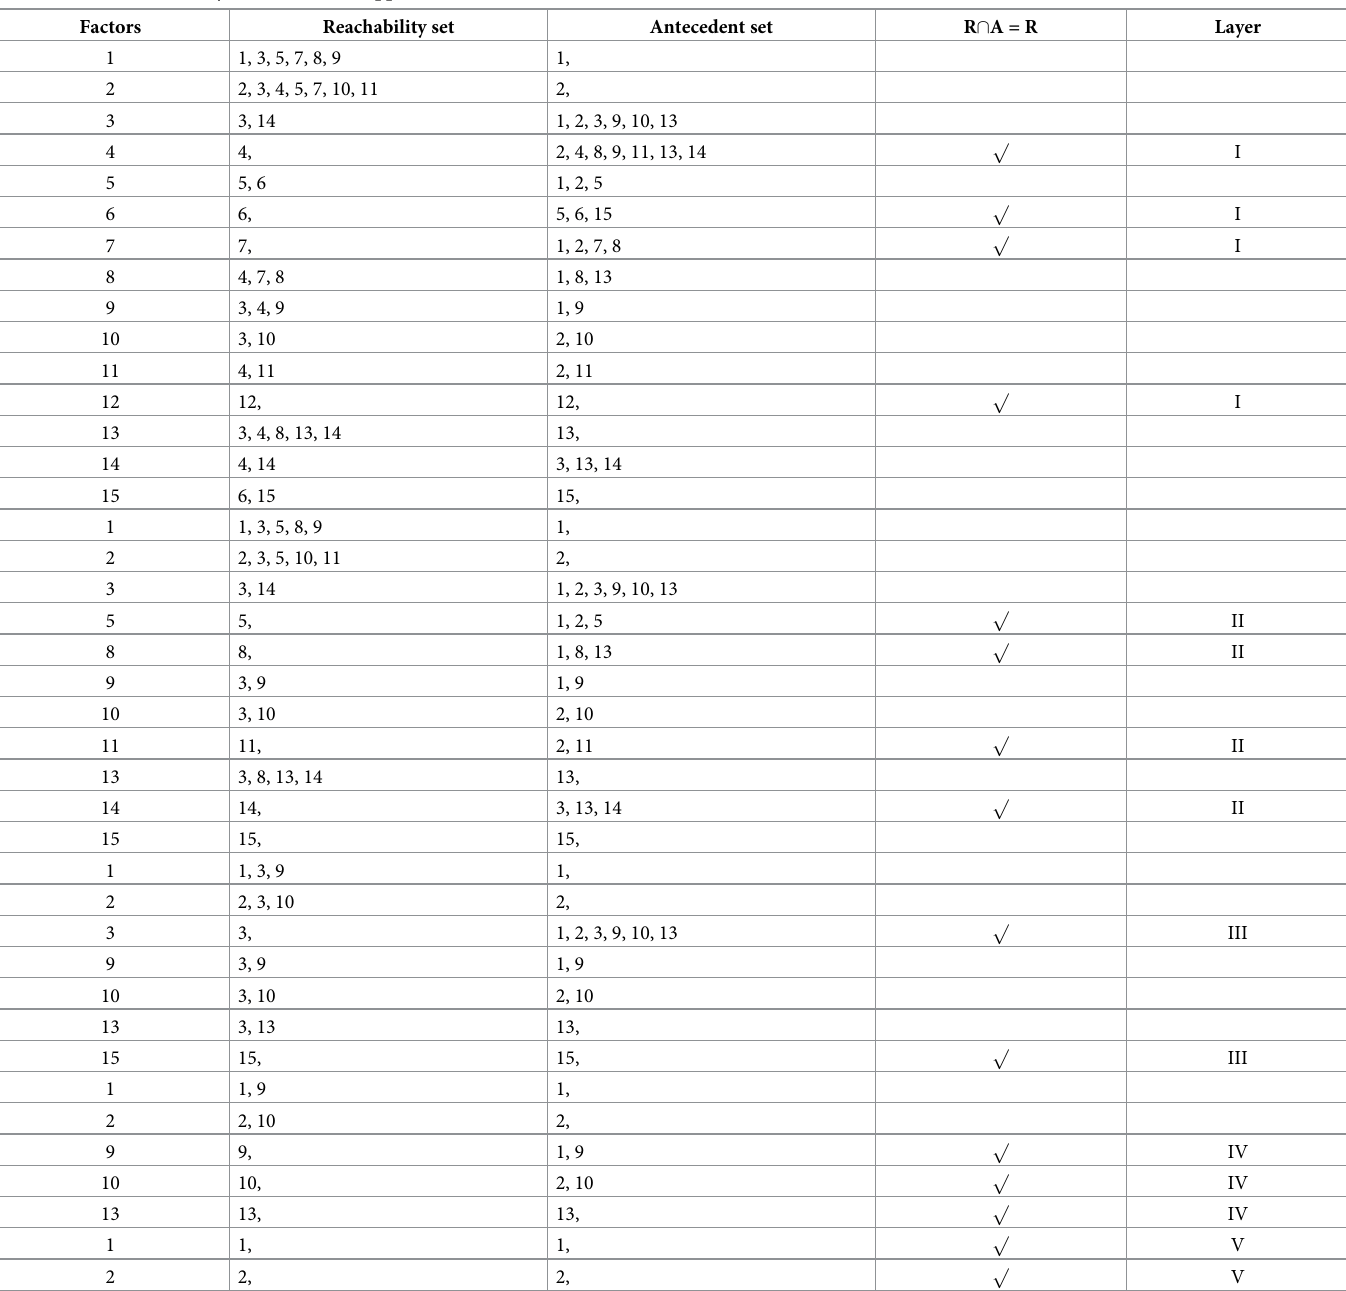
Table 7. Hierarchical analysis of traditional approach.